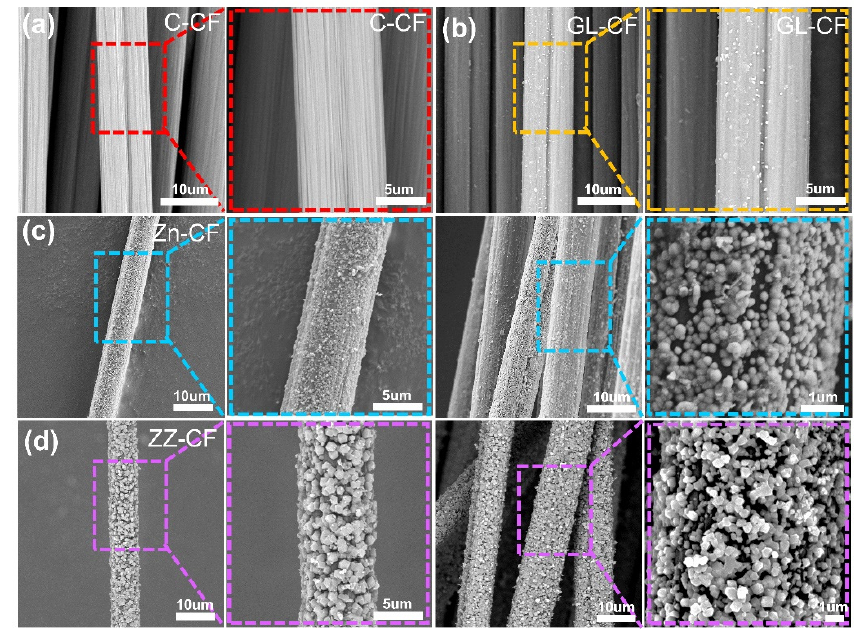
Figure 3. SEM images of ( a ) C–CF, ( b ) GL–CF, ( c ) Zn–CF, and ( d ) ZZ–CF,